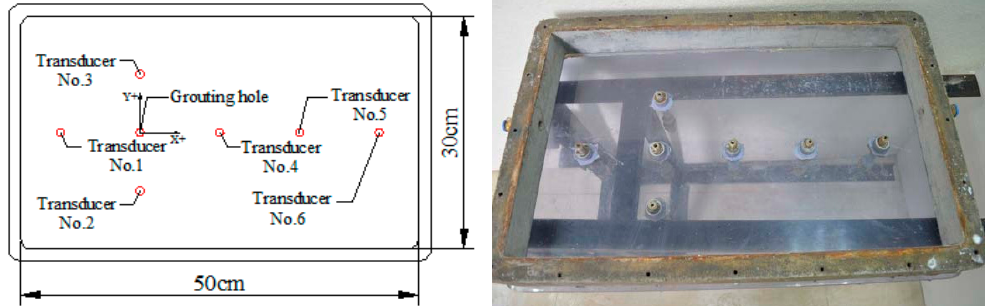
Figure 7. The layout chart and physical map of each transducer.